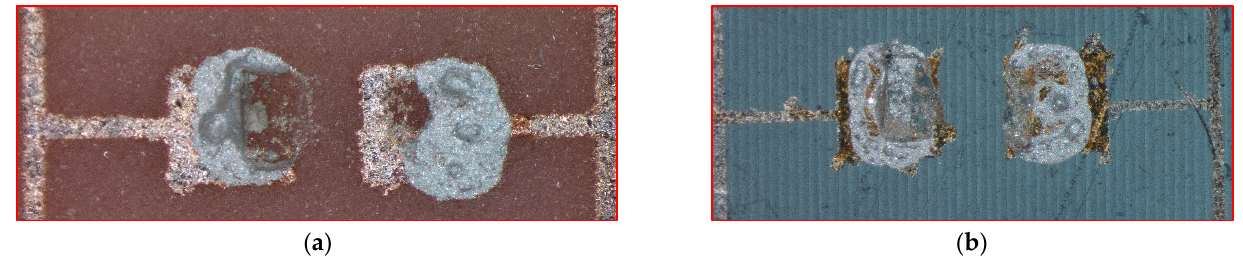
Figure 17. Fracture pattern after shear test. ( a ) FotoTec SL.E with ICA 2 cured for 30min at 120 ◦ C and ( b ) Luxaprint 3D mold with ICA 2 cured for 90 min at 120 ◦ C.